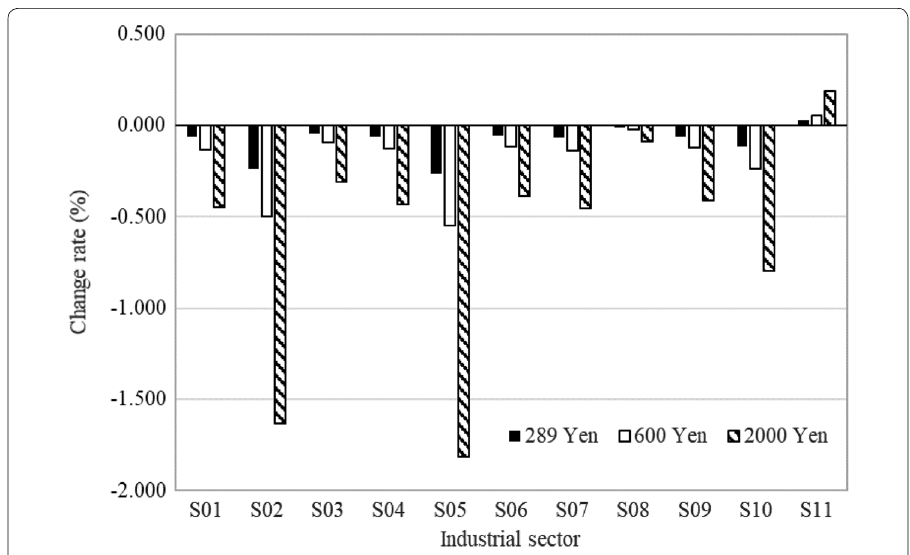
Fig. 2 The change rate of production of each sector in scenario 1 (substitution)